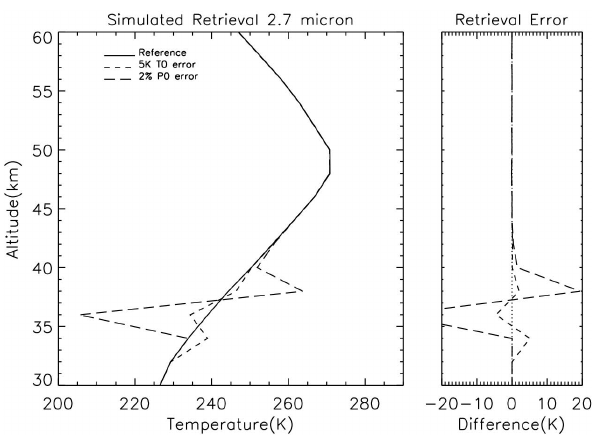
Fig. 9. Same as Fig. 7 but for the 2.7µm CO 2 band.